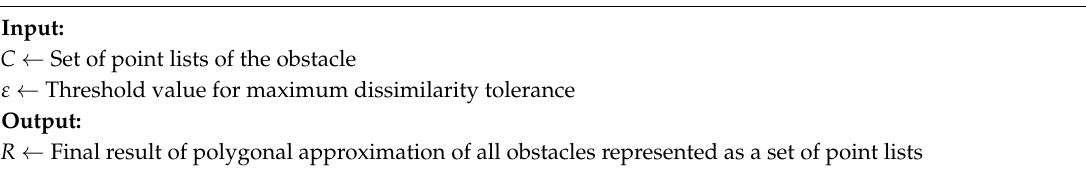
Algorithm 1. Pseudo Code of the Initial